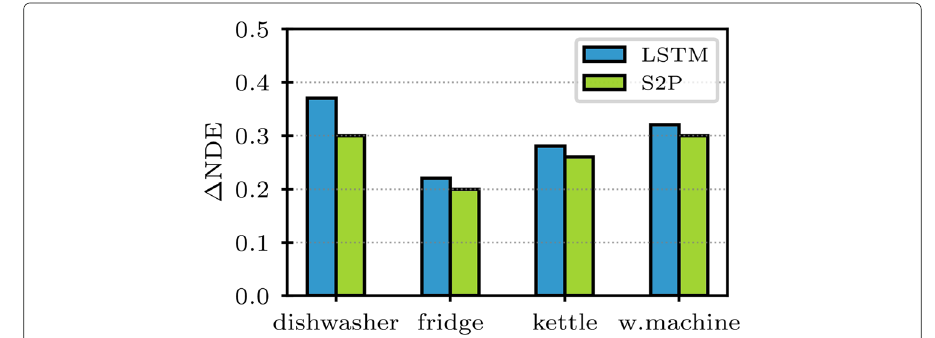
Fig. 7 Performance gap with regard to NDE for REFIT house